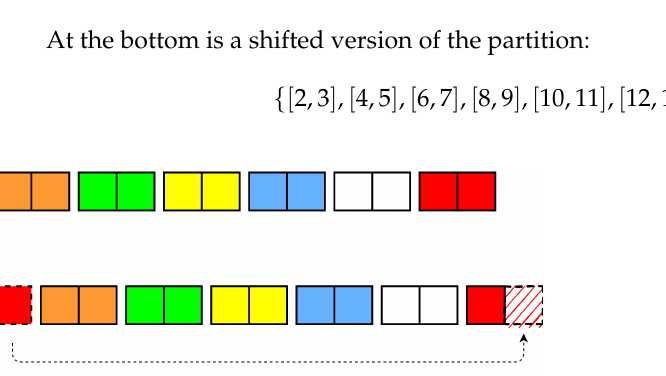
Figure 7. At the top is a bar of twelve cells partitioned into six supercells, two cells long each. At the bottom is a shifted version of the partition.